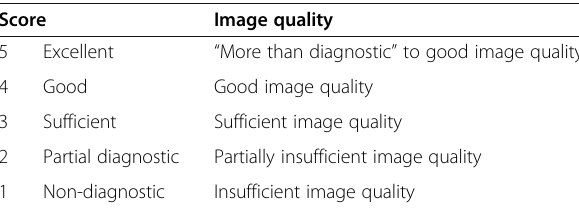
Table 3 Five-point Likert scale used for qualitative image assessment of tantalum structures